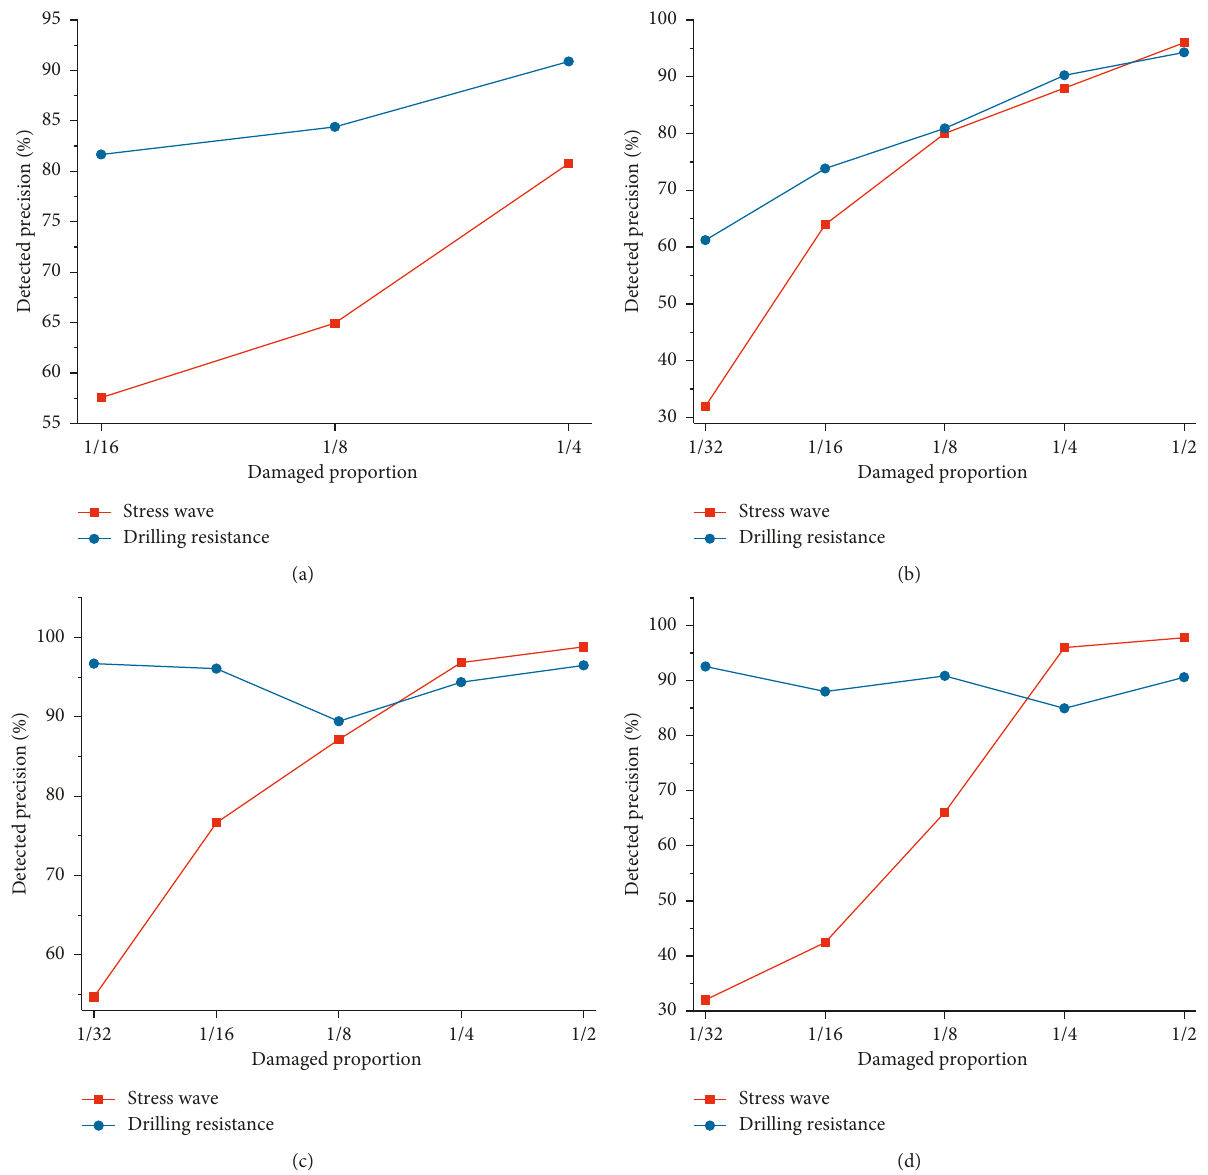
Figure 8: Curves of detected precision under different working conditions. (a) Specimen 1. (b) Specimen 2. (c) Specimen 3. (d) Specimen